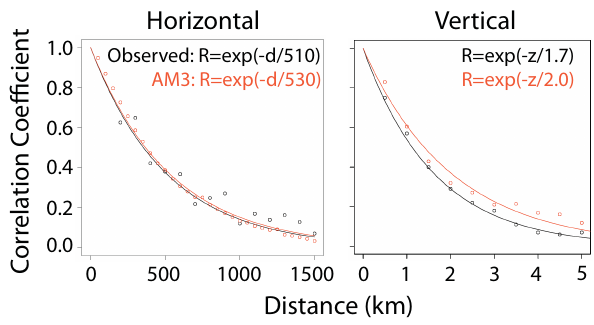
Figure 3. Error correlation length scales for the GEOS-Chem model simulation of tropospheric ozone in the US Intermountain West. The error correlations are relative to actual CASTNet and ozonesonde observations (in black) and relative to the GFDL AM3 model sampled in the Intermountain West region (in red). Statistics are computed for April–June 2010. The left panel shows the corre- lation coefficient ( R ) of the model error between pairs of CASTNet sites, plotted against the distance between sites. Values are for the 12 CASTNet sites in the Intermountain West (Fig. 1). The right panel shows the correlation coefficient of the model error between pairs of vertical levels (up to 8km altitude) for ozonesonde measurements from the IONS-2010 campaign in California (Cooper et al., 2011), plotted against distance between levels. Exponential fits to the data are shown inset, where d and z are horizontal and vertical distances in